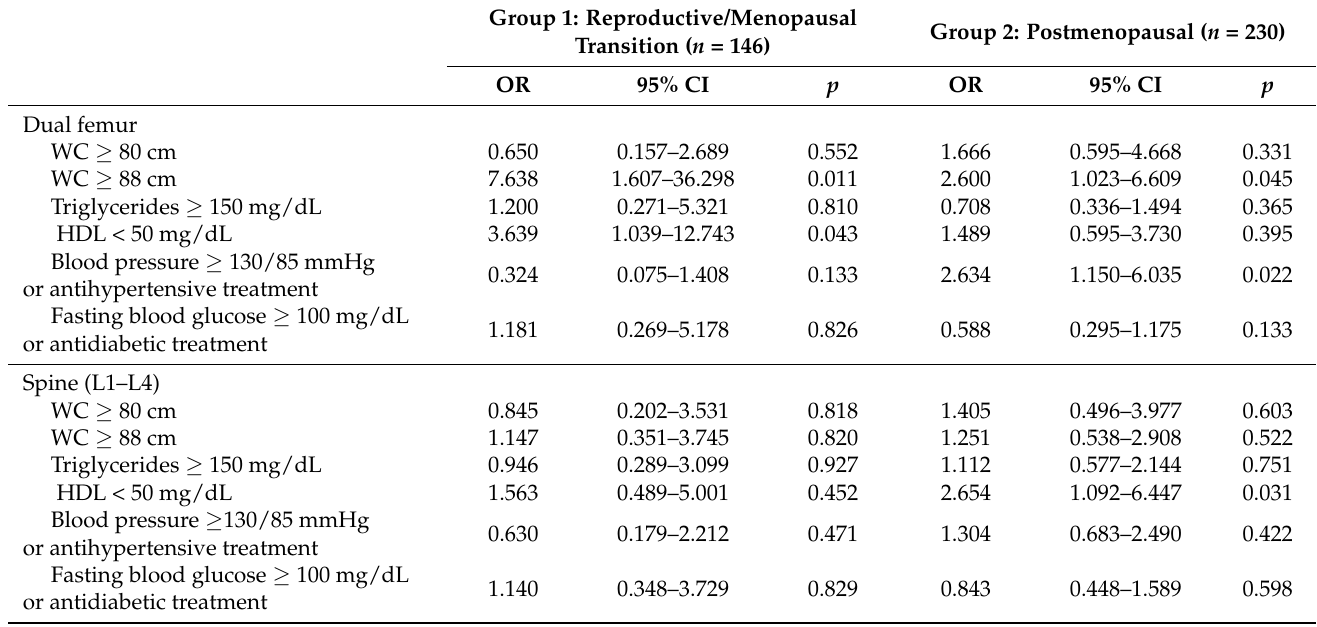
Table 4. Association between low bone mineral density (osteopenia/osteoporosis) in the dual femur and spine and components of MetS according to stages of reproductive aging a